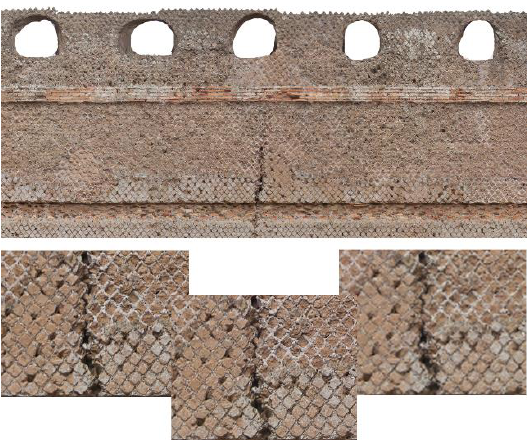
Figure 4: Portion of the wall’s orthoimage and three details at the considered scales (1:10, 1:20 and 1:50, respectively from left to right).